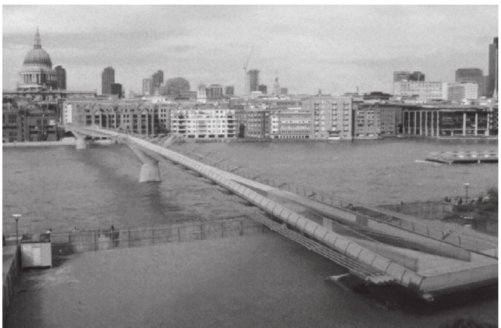
Figure 3: London Millennium Bridge looking north